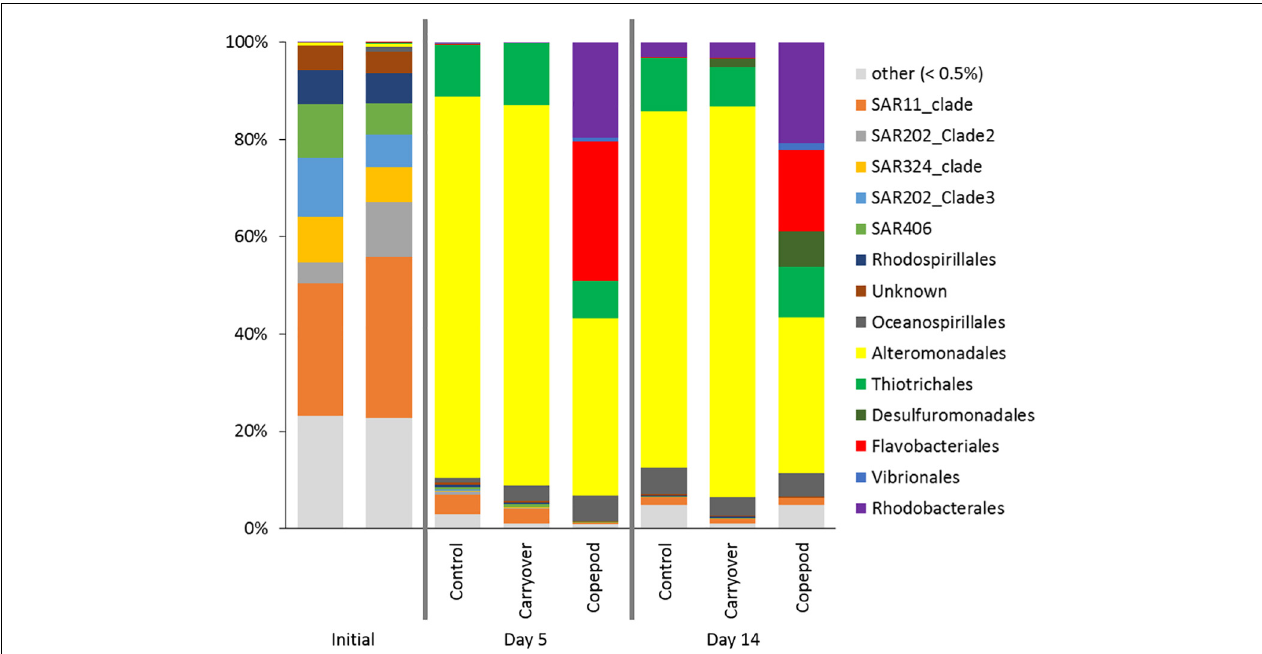
FIGURE 6 | 16S rRNA gene amplicons were used to determine community composition at the Order level at the initiation of the experiment (T0), and after Day 5 and Day 14 of the incubation for all treatments in the microbial remineralization experiment. The proportion of reads in a sample is grouped by ASV order, with “other” being all groups contributing to less than < 0.5% of the total reads.